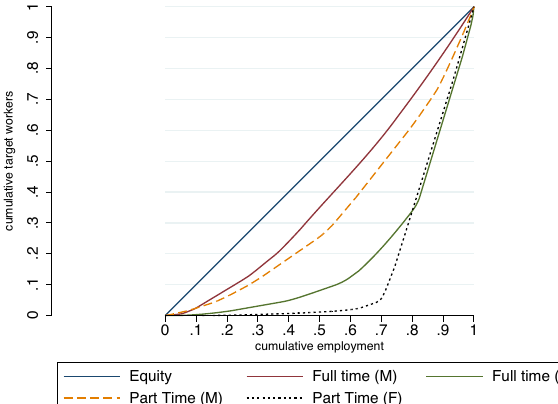
Fig. 6 Occupational segregation curve by gender and hours of work. The fi gure shows the occupational segregation of male and female workers with respect to hours of work. References Organisation for Economic Co-operation and Development (1985) The integration of women into the economy. OECD, Paris Organisation for Economic Co-operation and Development (1980) Women in employment. OECD, Paris Agrawal T (2016) Occupational segregation in the Indian labour market. Eur J Dev Res 28(2):330 – 351 Ahmed AM, Hyder A (2008) Sticky fl oors and occupational segregation: evidence from Pakistan. Pak Dev Rev 47(4):837 – 849 Alonso-Villar O, Del Río C (2010) Local versus overall segregation measures. Math Soc Sci 60(1):30 – 38 Alonso-Villar O, Del Río C (2017) The occupational segregation of African American women: its evolution from 1940 to 2010. Fem Econ 23(1):108 – 134 Alonso ‐ Villar O, Del Río C, Gradín C (2012) The extent of occupational segre- gation in the United States: differences by race, ethnicity, and gender. Ind Relat 51(2):179 – 212 Amuedo-Dorantes C, De la Rica S (2006) The role of segregation and pay structure on the gender wage gap: evidence from matched employer – employee data for Spain. Cont in Eco Anal Policy 5:1 Andlib Z, Khan AH (2018) Low female labor force participation in Pakistan: causes and factors. Glob Soc Sci Rev 3(3):237 – 264 Anker R (1998) Gender and jobs: sex segregation of occupations in the world. International Labour Organisation